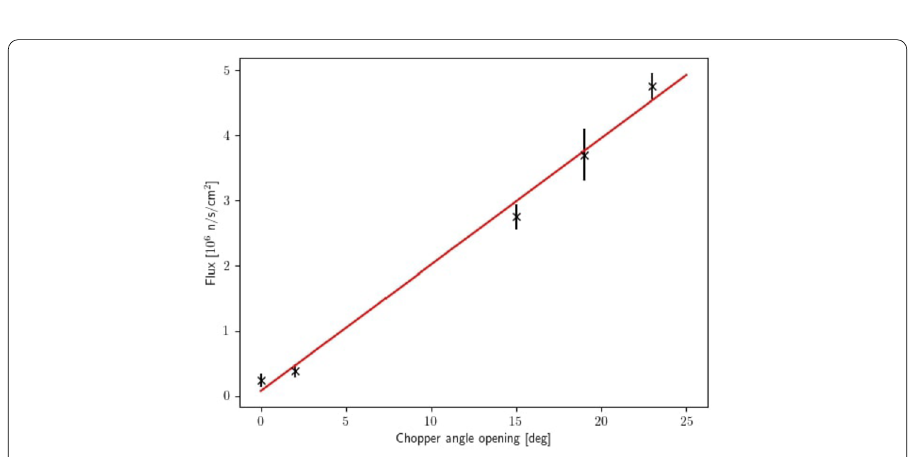
Figure 13 Corrected flux measured with the I-BM vs. chopper opening angle with the white wavelength spectrum. The figure shows four different settings of SCs and a background measurement (first black